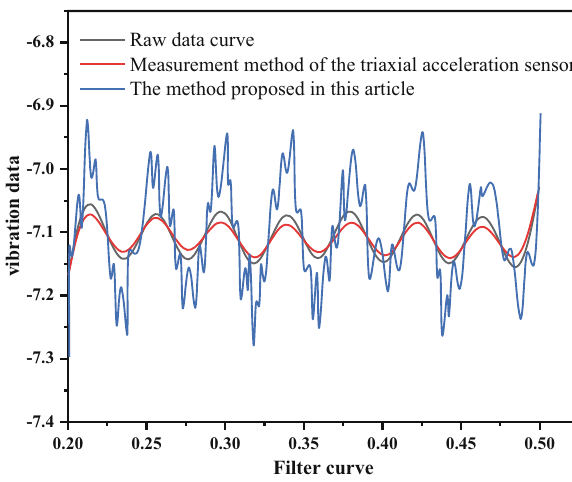
Figure 7: Comparison of 20 Hz and 200 μ m data fi ltering curves.